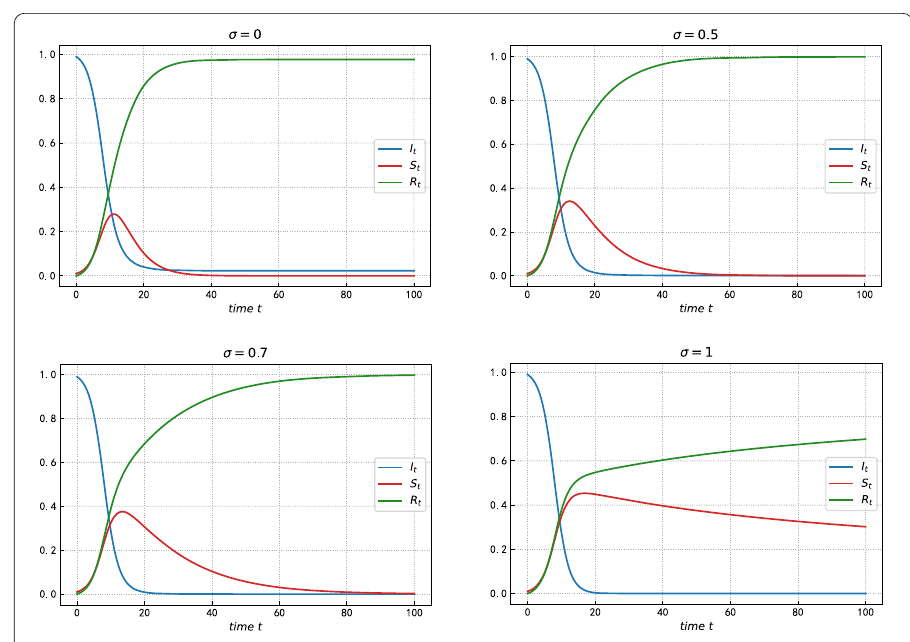
Figure 3 Trajectories of α -paths I α t , S α t , and R α t with α = 0.4, σ = 0,0.5,0.7, and 1